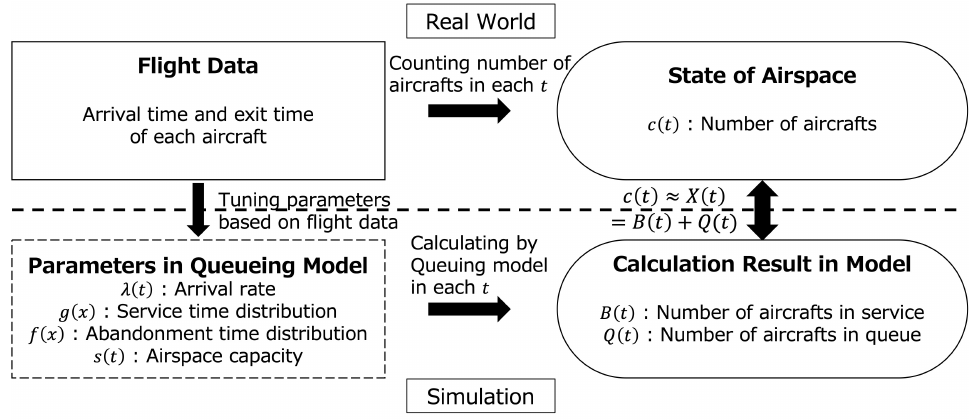
Figure 2. Methodology to analyze current airspace.